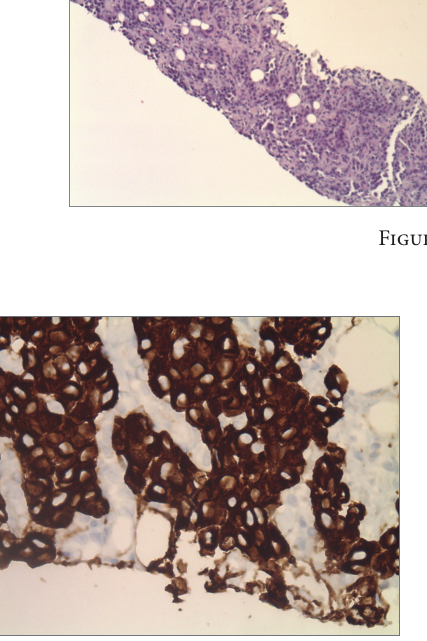
Figure 4: Biopsy of mass showing strongly CK7 positive. Figure 5: Biopsy of mass showing TTF-1 weakly